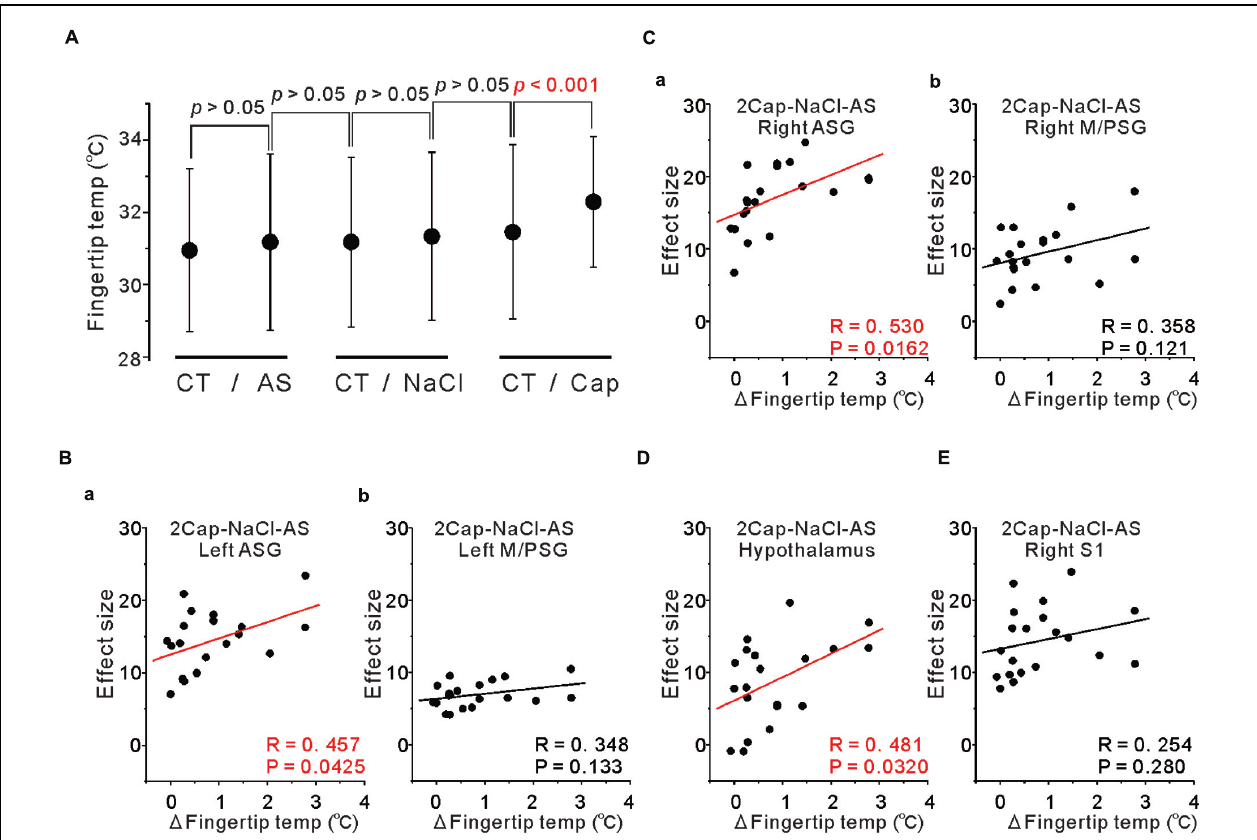
FIGURE 7 | Correlation between fingertip temperatures and effect sizes at the peak coordinates. (A) The fingertip temperature changes calculated by averaging for 15 s before and after AS, NaCl and capsaicin sessions. Statistical analyses were performed with a paired t -test. CT; control. (B) Correlation between the fingertip temperature increases and the effect sizes at respective peak coordinates in the left ASG (a) and in the left M/PSG (b) obtained in the group analysis of the comparison [2 × Capsaicin–NaCl–AS]. (C) Correlation between the fingertip temperature increases and the effect sizes at respective peak coordinates in the right ASG (a) and in the right M/PSG (b) obtained in the group analysis of the comparison [2 × Capsaicin–NaCl–AS]. (D) Correlation between the fingertip temperature increases and the effect sizes at the peak coordinates in the hypothalamus (–6, –8, –2) obtained in the group analysis of the comparison [2 × Capsaicin–NaCl–AS]. (E) Correlation between the fingertip temperature increases and the effect sizes at the peak coordinates in the right S1 of postcentral gyrus (64, –18, 24) obtained in the group analysis of the comparison [2 ×